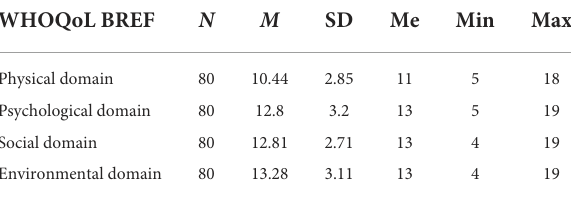
TABLE 5 Domains of quality of life according to the WHOQoL BREF questionnaire ( N = 80).